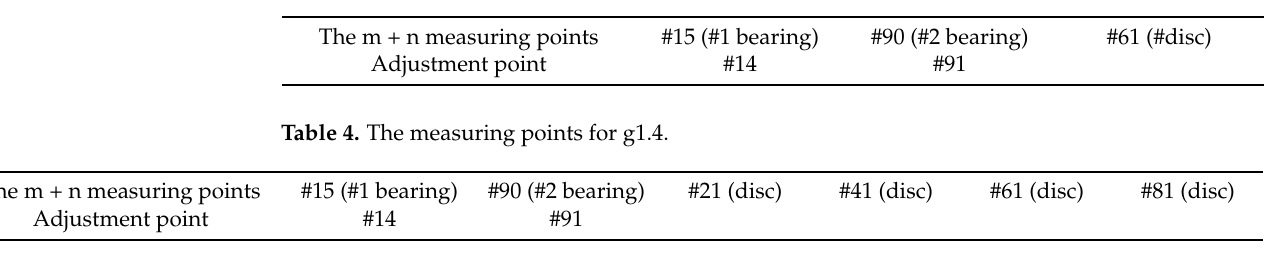
Table 3. The measuring points for g1.1.